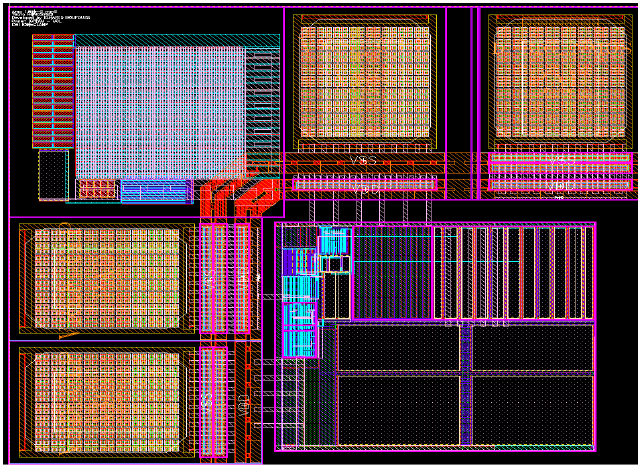
Figure 6. Final layout of the voltage